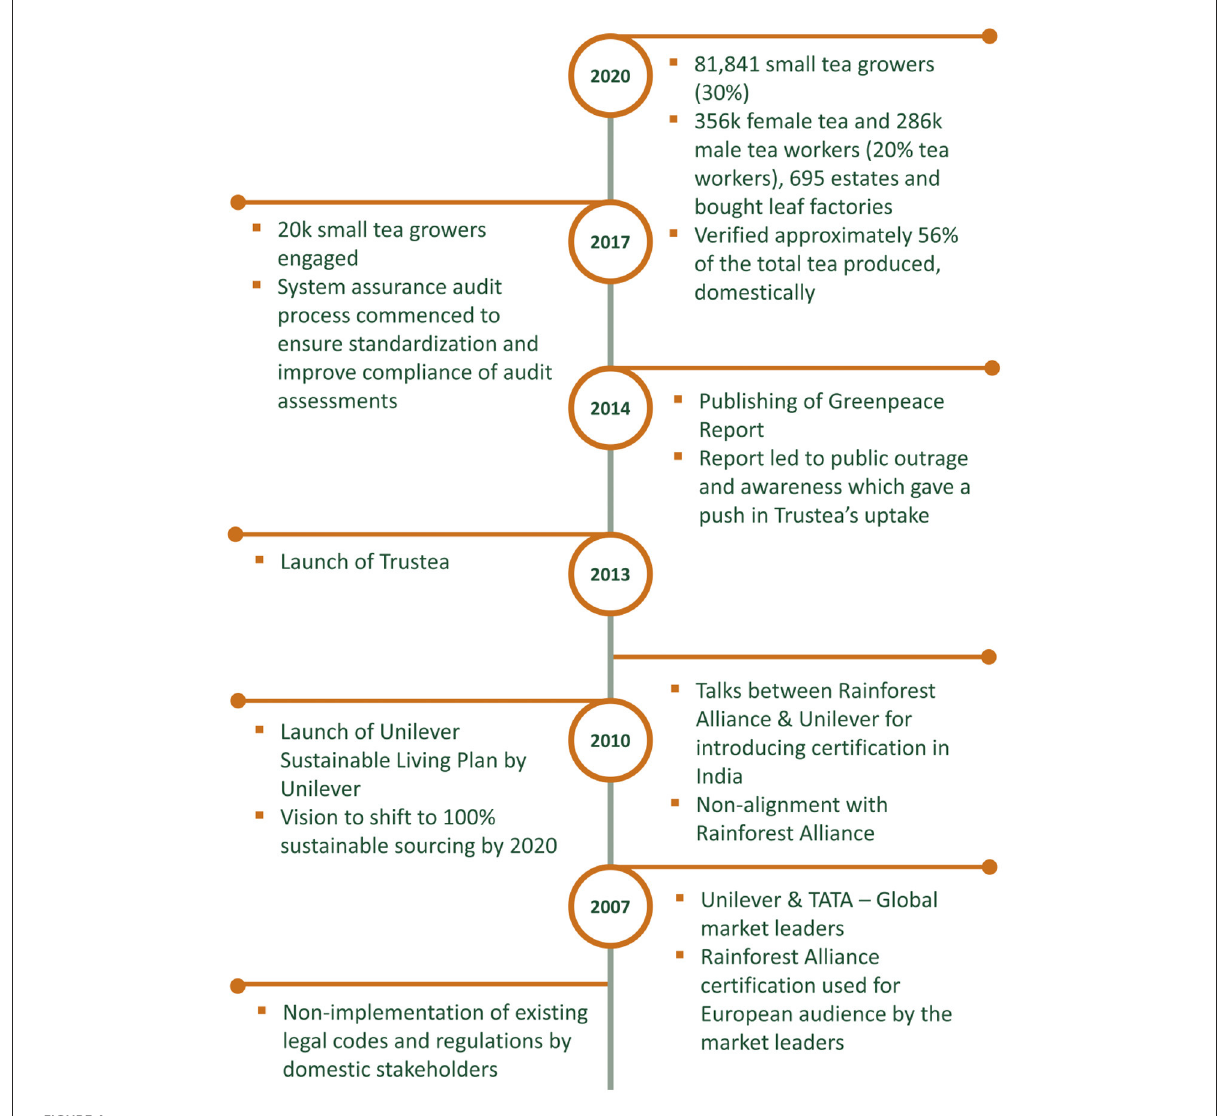
FIGURE4 Timeline of key events in